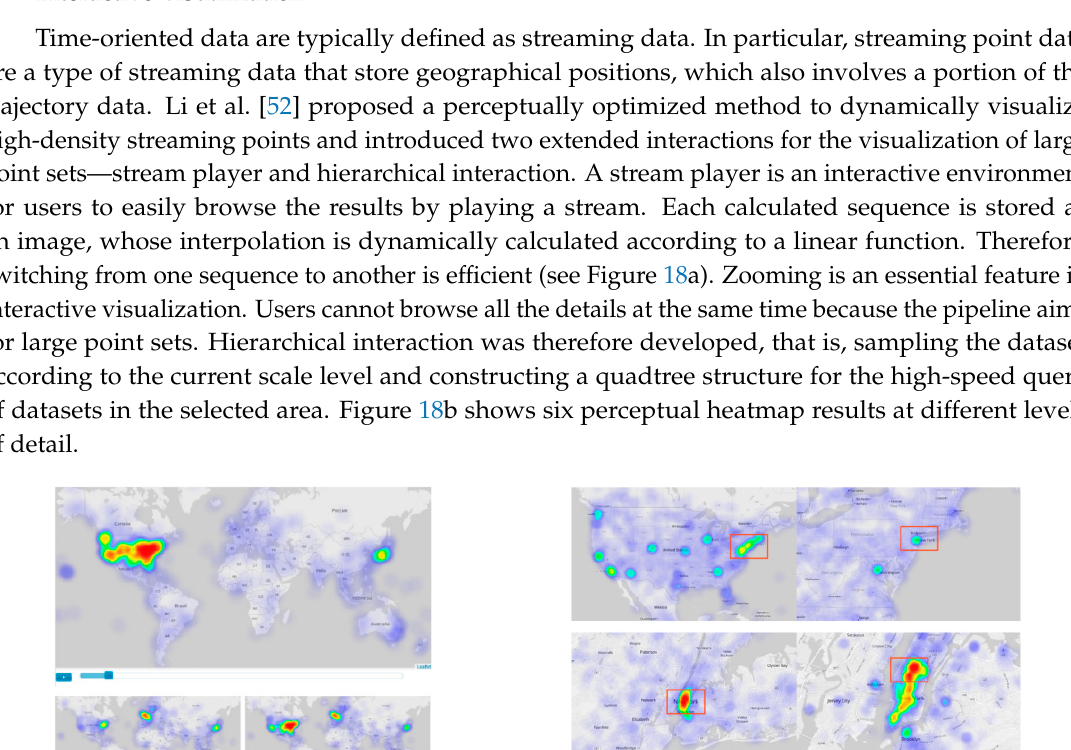
Figure 17. Comparison between general heatmaps ( left ) and reverse heatmaps ( right ) of Beijing urban area [51].